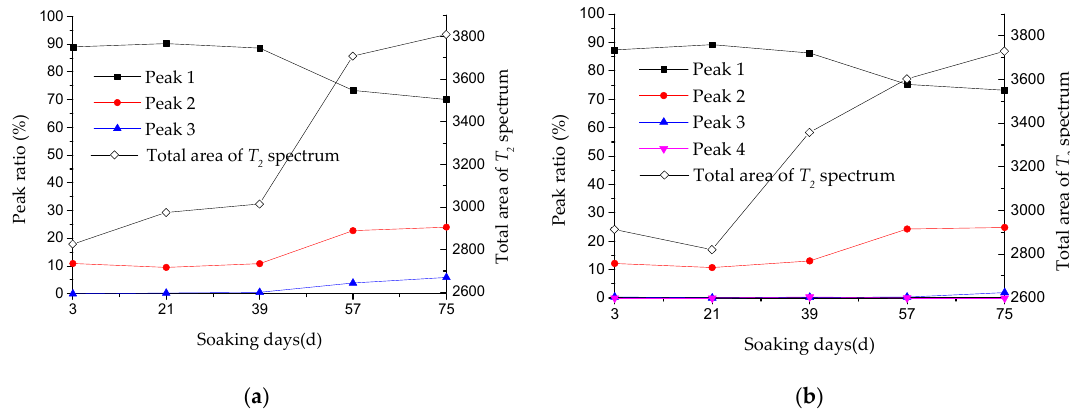
Figure 11. T 2 spectrum area of concrete under sodium sulfate erosion: ( a ) J5; ( b ) J4.